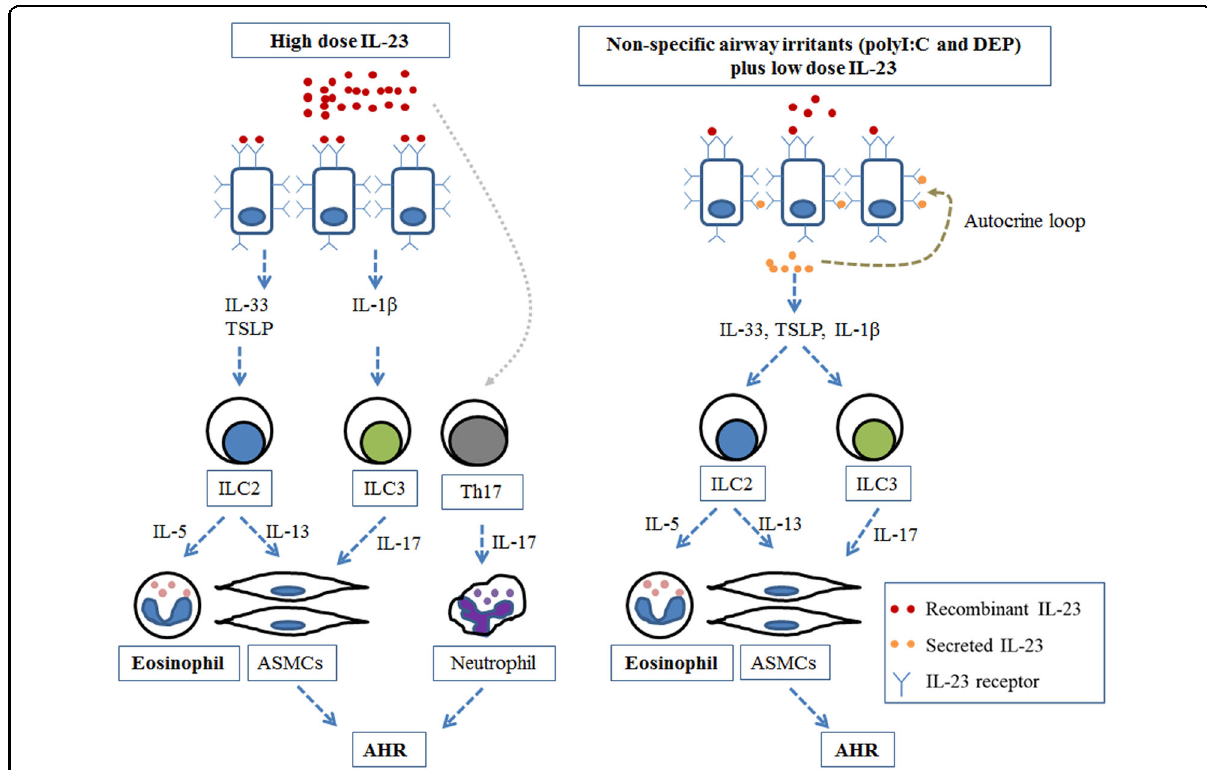
Fig. 8 A plausible mechanism for the development of nonallergic eosinophilic asthma. a Airway epithelial cells stimulated by high doses of IL-23. High-dose IL-23 binds to IL-23R and induces the secretion of IL-33, TSLP, and IL-1 β from airway epithelial cells; these factors can activate ILC2s and ILC3s. Activated ILC2s and ILC3s cause eosinophilic airway in fl ammation and AHR. In addition, high-dose IL-23 contributes to the development of AHR by directly activating Th17 cells and neutrophils. b Airway epithelial cells stimulated by low doses of IL-23 plus nonspeci fi c airway irritants (polyI: C or DEPs). Low-dose IL-23 plus nonspeci fi c airway irritants induce the secretion of a small amount of IL-23 from airway epithelial cells and increases the expression of IL-23R on airway epithelial cells. The secreted IL-23 forms a positive autocrine loop by binding to the increased IL-23R, thereby inducing secretion of IL-33, TSLP, and IL-1 β (as with the high-dose of IL-23). Activated ILC2s and ILC3s cause eosinophilic airway in fl ammation and